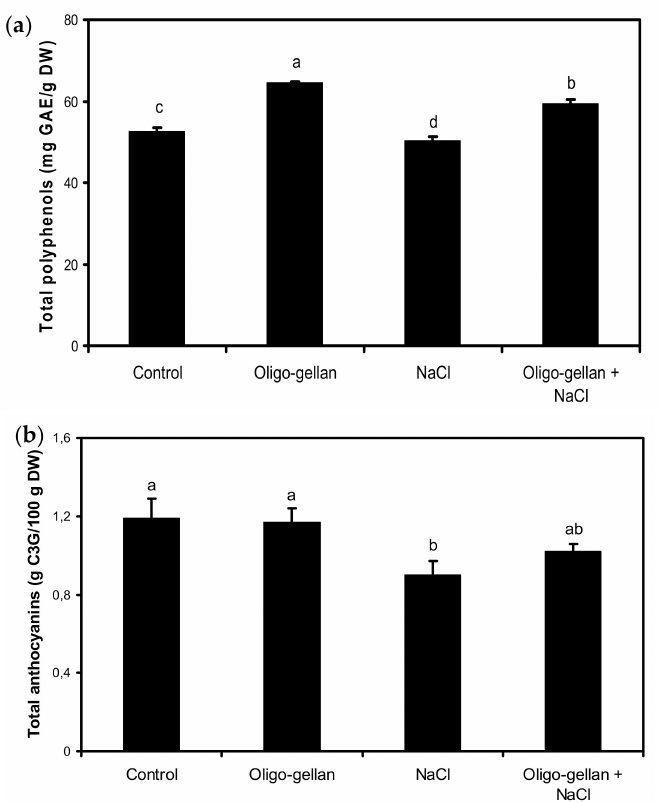
Figure 2. E ff ects of oligo-gellan pretreatment (100 ppm) and salt stress (100 mM NaCl) on total polyphenols ( a ) and total anthocyanins ( b ) of red perilla plants. Bars represent means of three biological replicates ± standard deviations. Di ff erent letters indicate statistical di ff erences at p ≤ 0.05 (Tukey’s